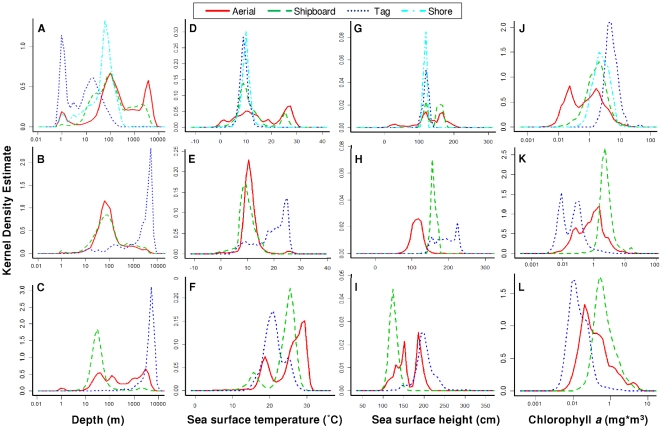
Kernel density estimates of environmental variables.Depth (A–C), sea surface temperature (D–F), sea surface height (G–I), and chlorophyll a (J–L) density estimates for marine mammals (A, D, G, J), seabirds (B, E, H, K), and sea turtles (C, F, I, L). Observations collected by aerial surveys (solid red line), shipboard surveys (dark green long dashed line), tag (dark blue short dashed line), and shore (light blue dashed and dotted line, only for marine mammals) were used to sample environmental variables. Note that depth and chlorophyll a graphs are on a log scale.